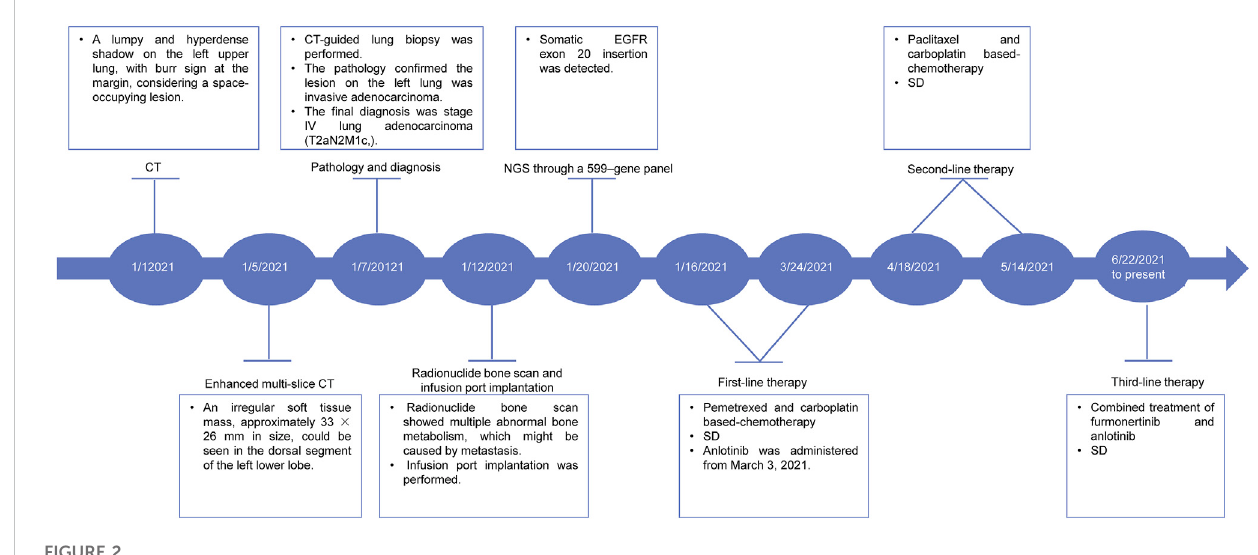
FIGURE 2 Case timeline.